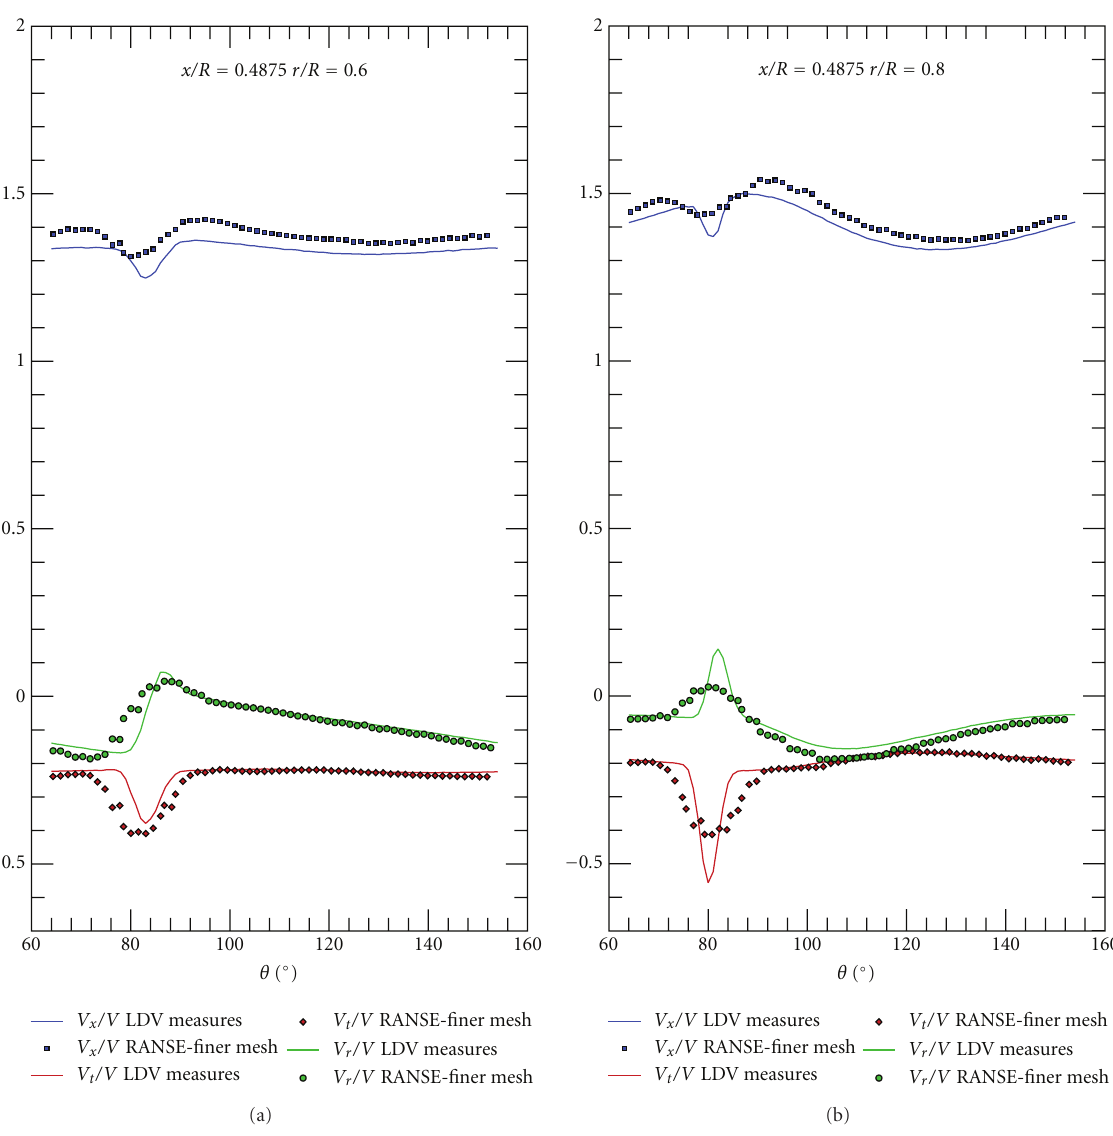
Figure 15: Axial, tangential, and radial vorticity distributions at x/R = 0.4875, r/R = 0.60, and r/R = 0.80. Comparison between LDV and RANSE (single-blade angular